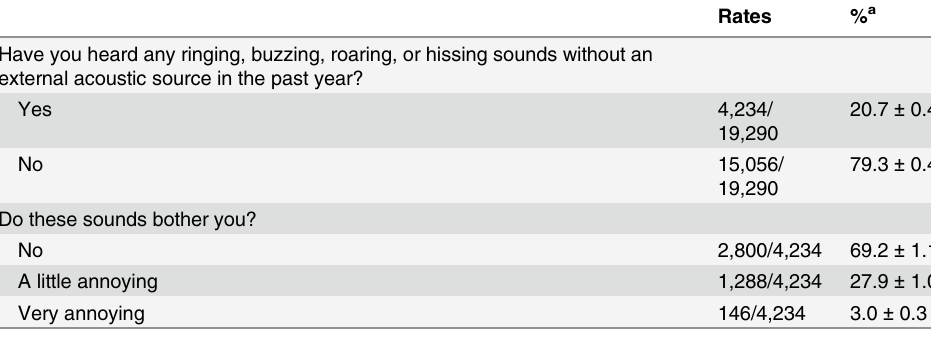
Table 1. Prevalence and Severity of